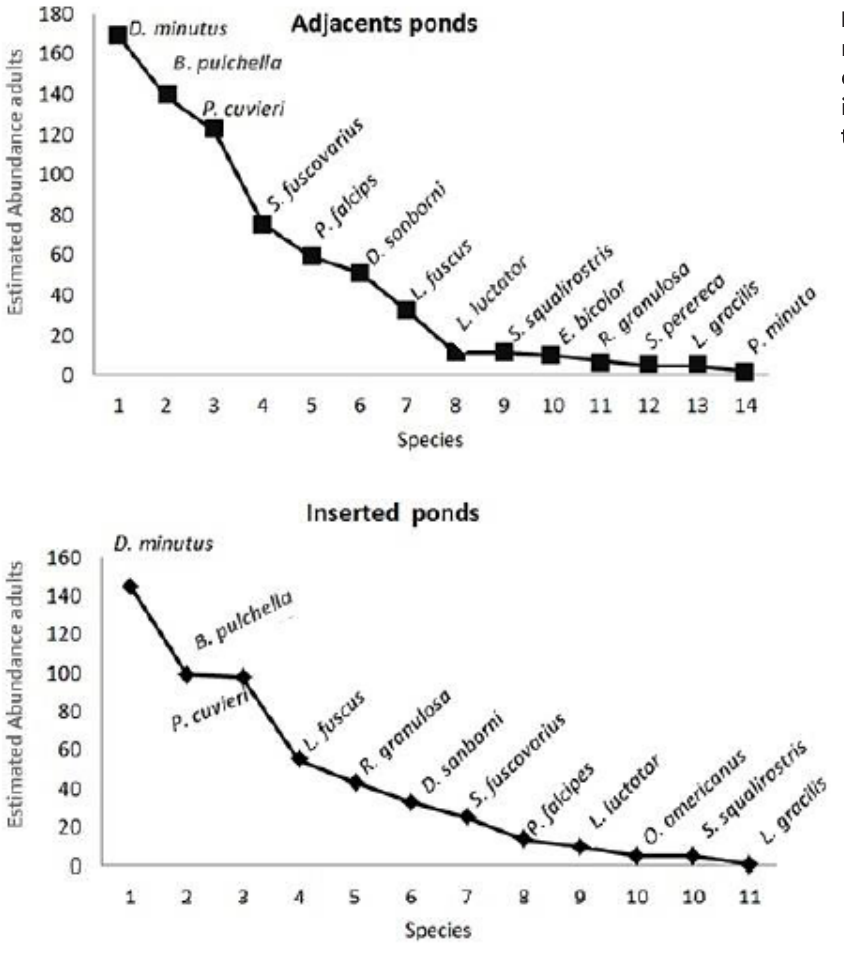
Figure 4. Species ranking of adult anurans collected in ponds inserted in and adjacent to soybean